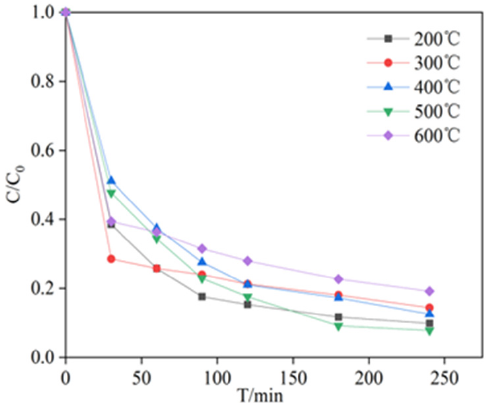
Figure 3. Effect of calcination temperatures on degradation of PCA by PDS catalyzed with MnFe 2 O 4 . Experimental conditions: [PCA] = 20 mg/L, pH = 7.00 ± 0.02, [PDS] = 2.4 mM, [MnFe 2 O 4 ] = 1.3 g/L, and T = 25 °C.